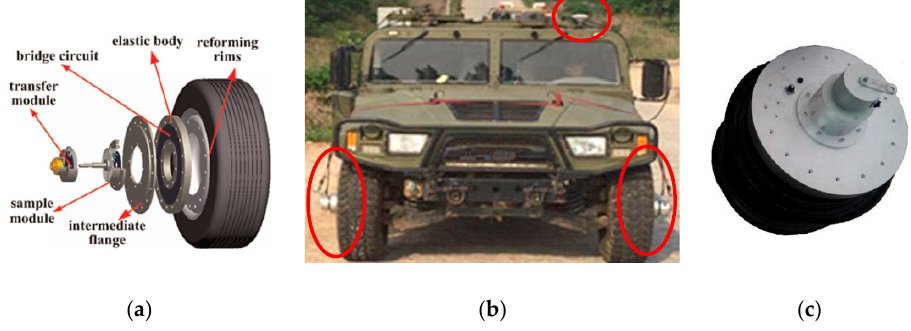
Figure 4. ( a ) The diagram of the tire with WFS, ( b ) The vehicle with WFS system, ( c ) The rim with WFS.